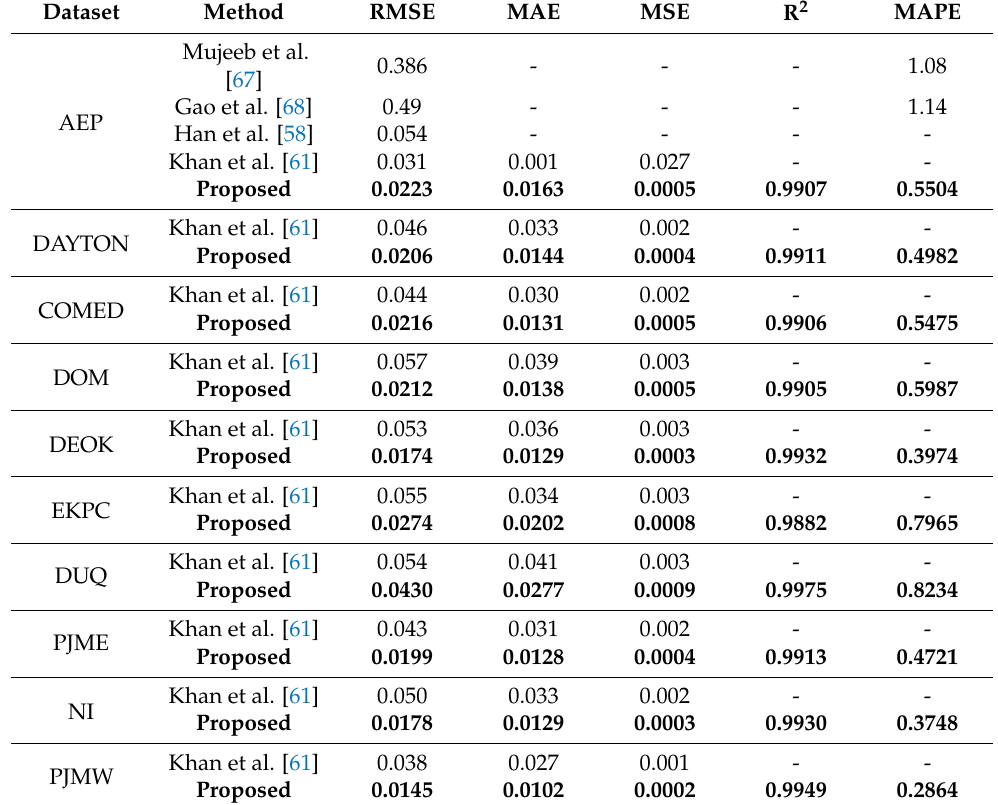
Table 5. Performance comparison of the proposed model with state-of-the-art forecasting methods over the PJM hourly